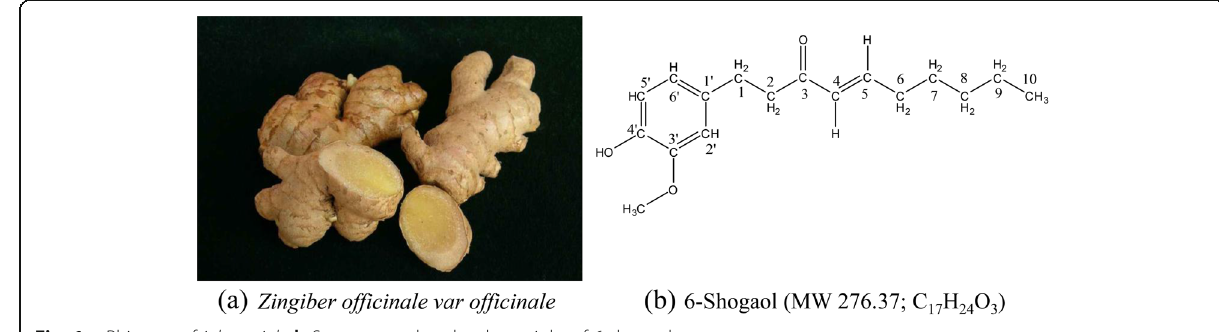
Fig. 1 a Rhizome of jahe gajah . b Structure and molecular weight of